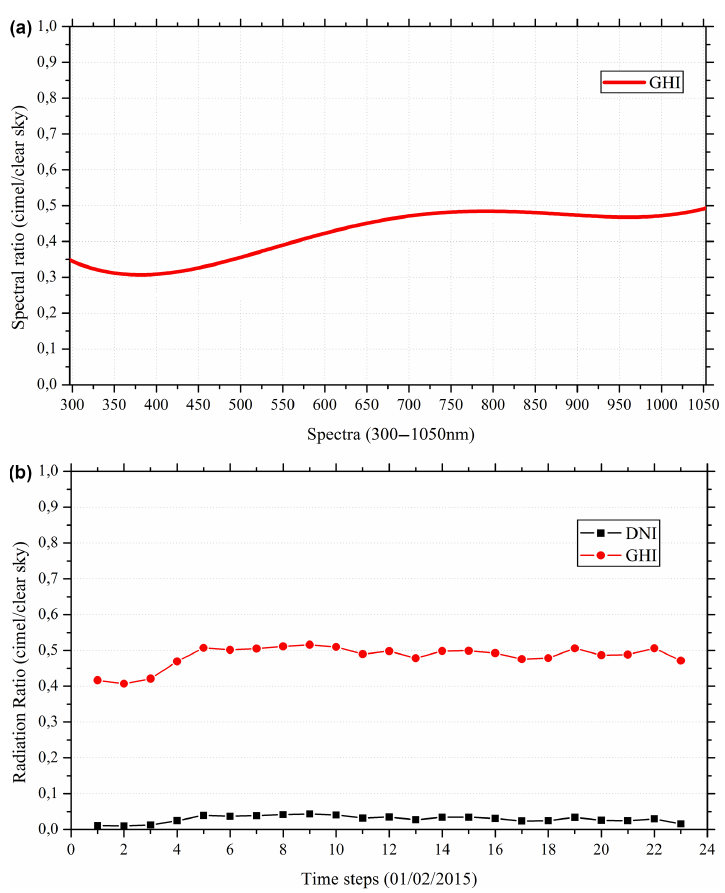
Figure 7. (a) The spectral effect of the extreme dust event of 1 February 2015 at the Athens station as depicted by the ratio of the AERONET Cimel sun photometer irradiance to the clear-sky irradiance calculated with a RTM for the same atmospheric conditions. Note the increased attenuation at shorter wavelengths. (b) Temporal evolution of the hourly value of the ratio for the GHI and DNI output by the